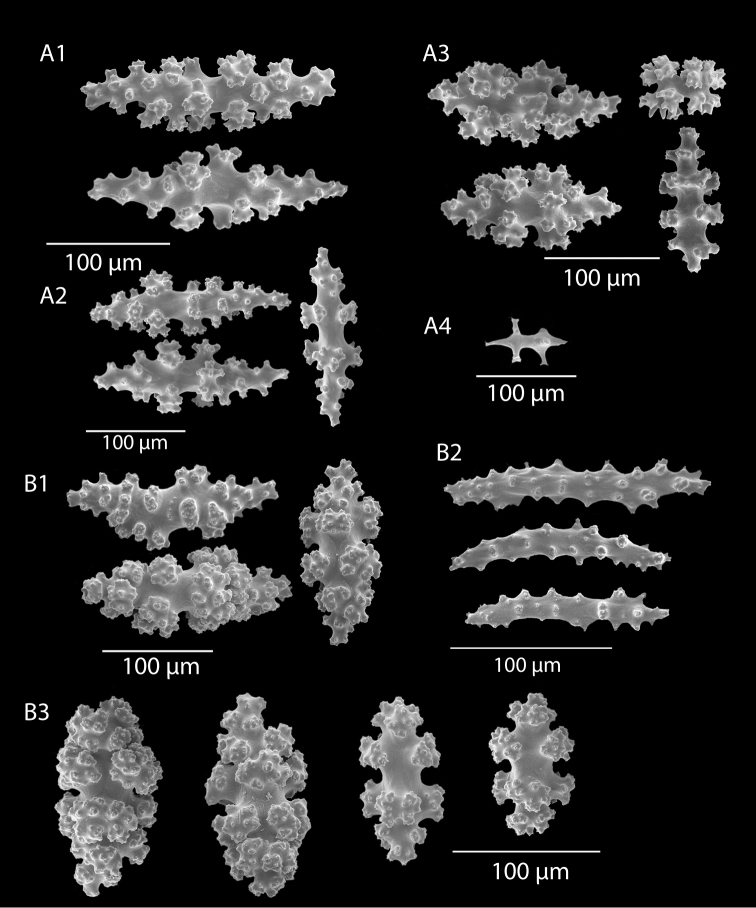
Chromoplexauramarki, SEM images. ASBMNH 423061 A1 Double dunce-cap forms A2 Slightly smaller double dunce-cap forms A3 Coenenchymal sclerites A4 Anthocodial form BSBMNH 423072 B1 Double dunce-cap sclerites B2 Elongated spindles from coenenchyme B3 Coenenchymal sclerites. Images match variety shown in Williams 2013a (figs 14–17).